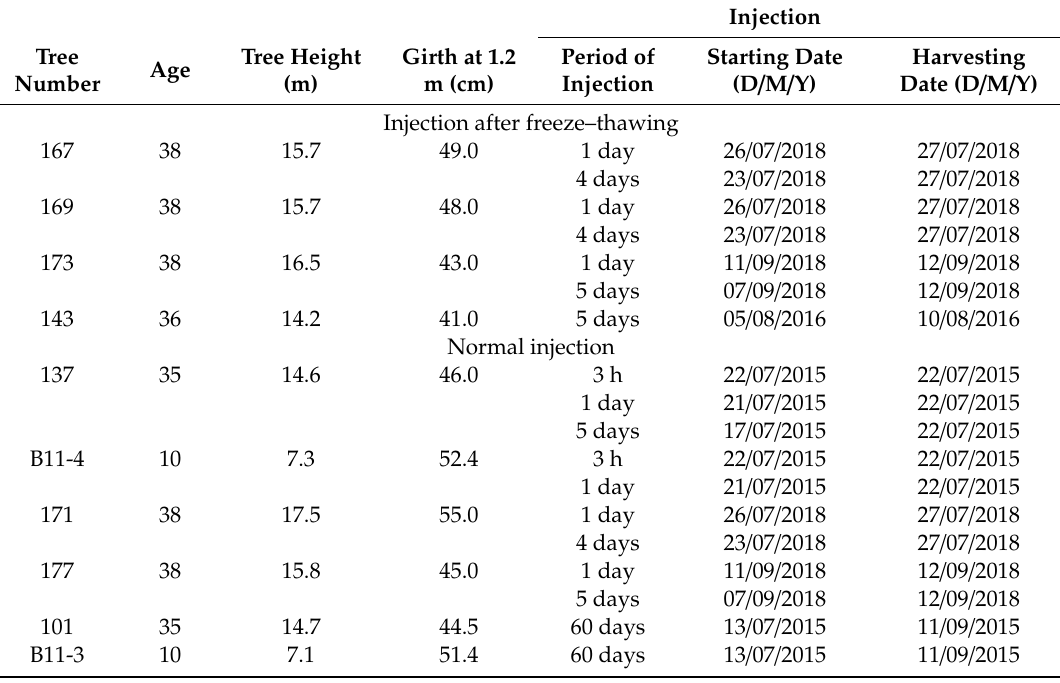
Table 1. Basic information on the